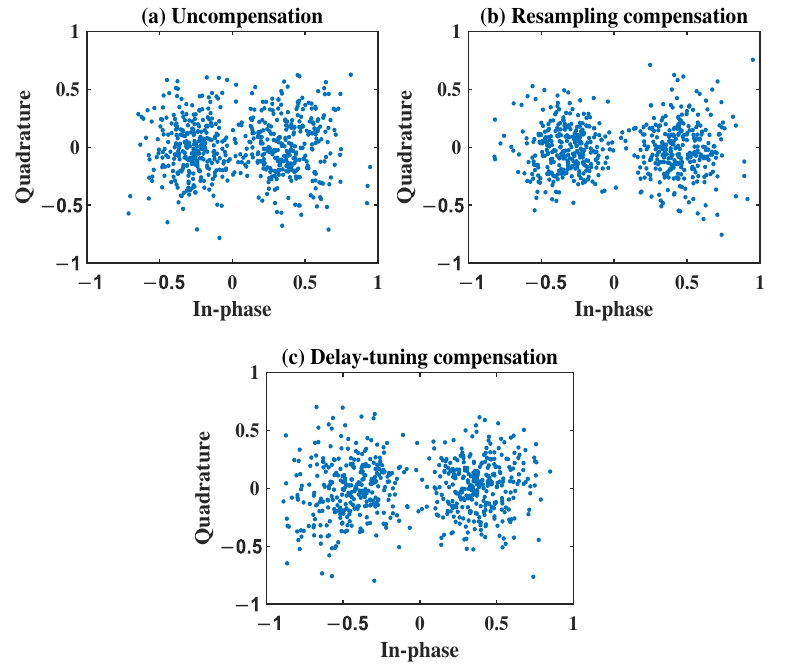
Figure 16. The uncoded constellation under different communication schemes of the lake